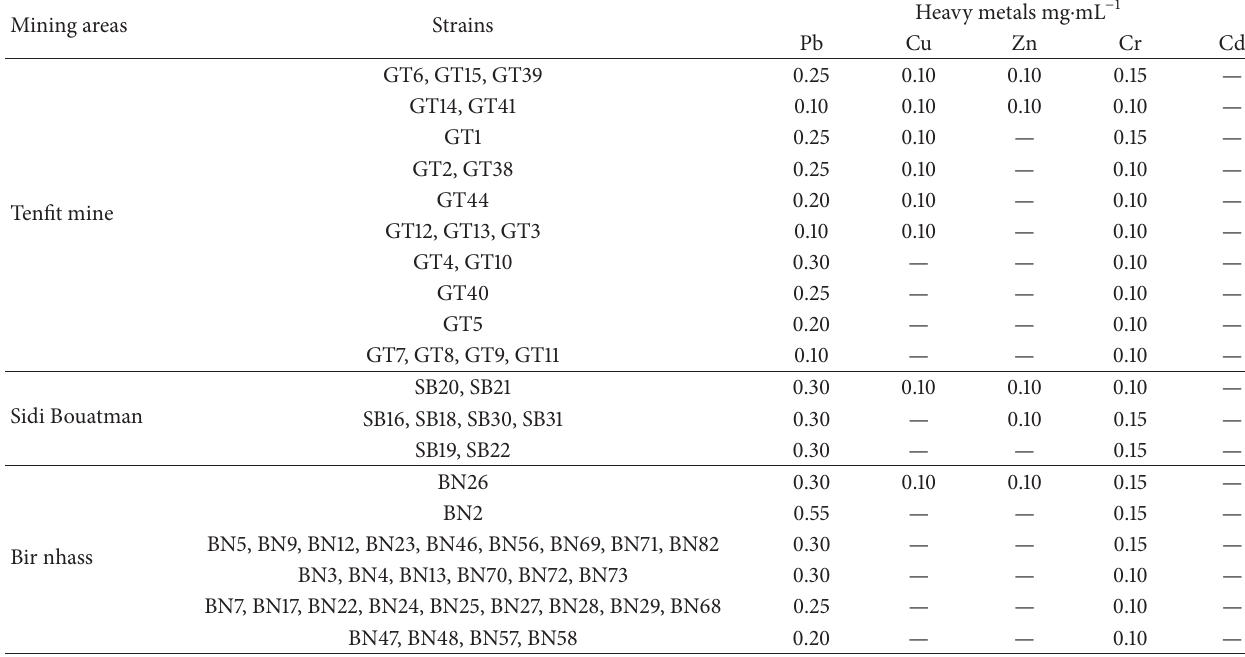
Table 2: Heavy metals tolerance in actinobacteria from mining areas. Mining areas Strains